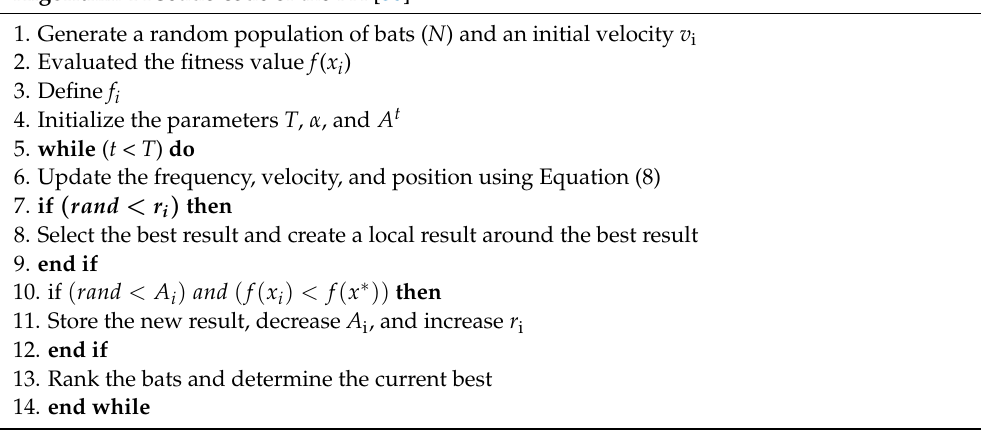
Algorithm 4 Pseudo code of the BA